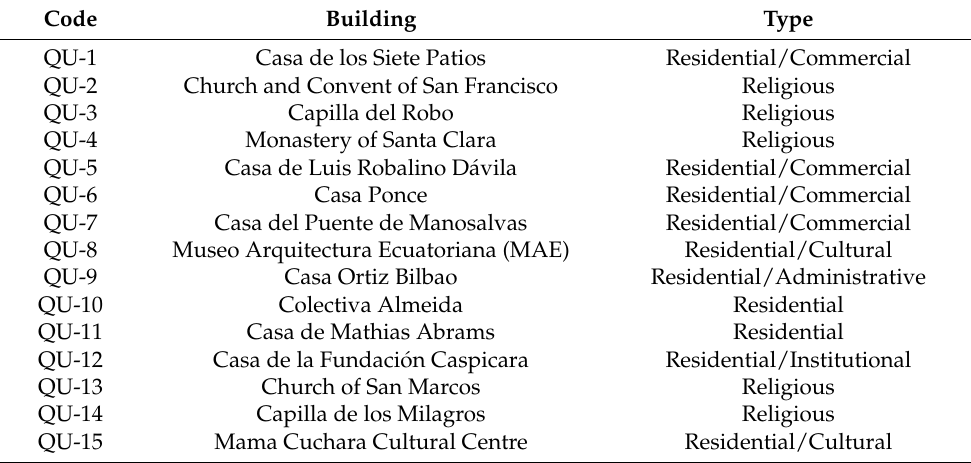
Table 1. List of the selected heritage